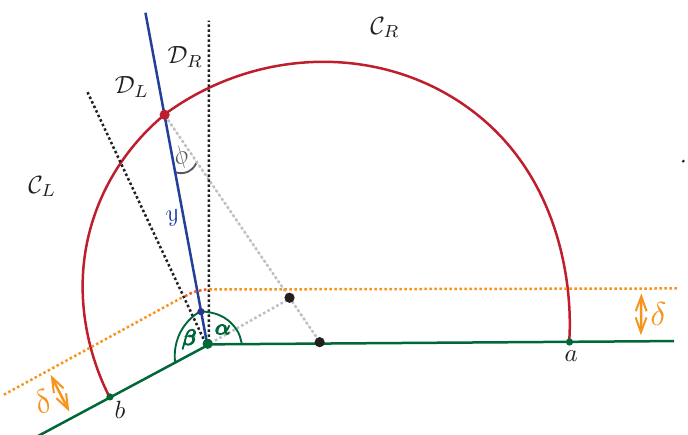
Figure 13. Constant time slice of the two AdS 3 patches, glued together along the straight blue line representing the defect. (cid:11) (right) and (cid:12) (left) are the opening angles of the patches on each side of the defect. The defect extends the space and its contribution is encoded in the regions ; , D L D R while ; are the parts of the AdS 3 spaces outside the defect extension. The cuto(cid:11) is represented C L C R by a dotted orange curve and is extended as a circular arc in the region of the defect. The red curve represents the RT surface corresponding to the region anchored at the AdS boundary at points a and b . It consists of two circular arcs of di(cid:11)erent radii which are connected smoothly at the location of the defect. The centers of the relevant nested circles are depicted as black